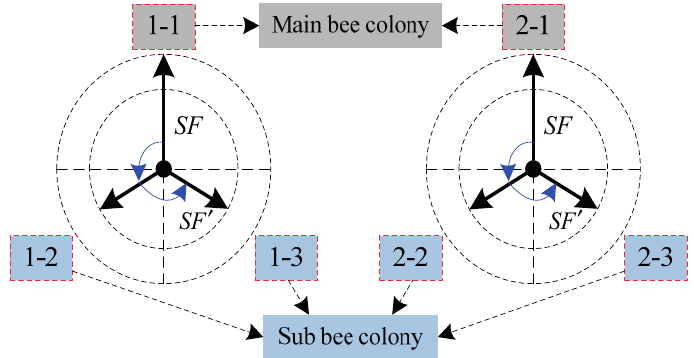
Figure 6. Schematic diagram of multi-group single point